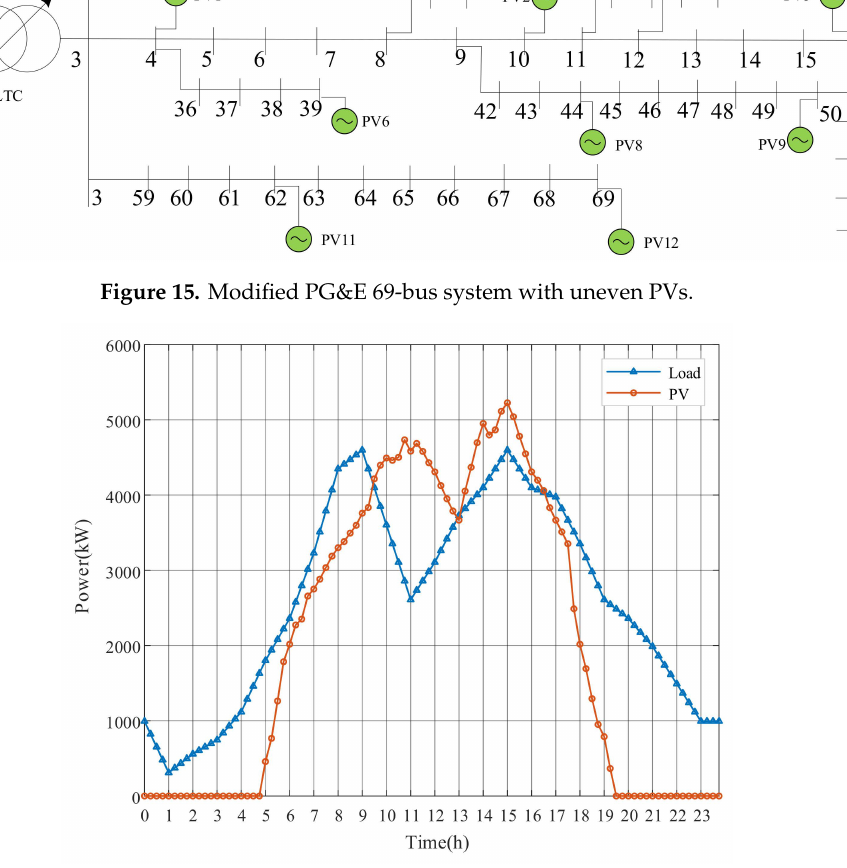
Figure 16. The aggregate daily load profile and forecasted PV power profile of Case